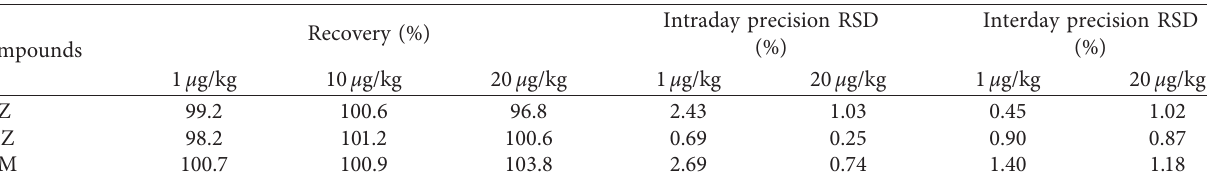
Table S3: recoveries of different quantitative modes in- cluding external standard, matrix matching, and isotope dilution in six milk samples ( n � 3). Table S4: linearity, LOD, and LOQ of the method. Figure S1: chromatography of three SAs. Figure S2: recoveries of different quantitative analysis modes of three target compounds in different elution conditions. ( Supplementary Materials )